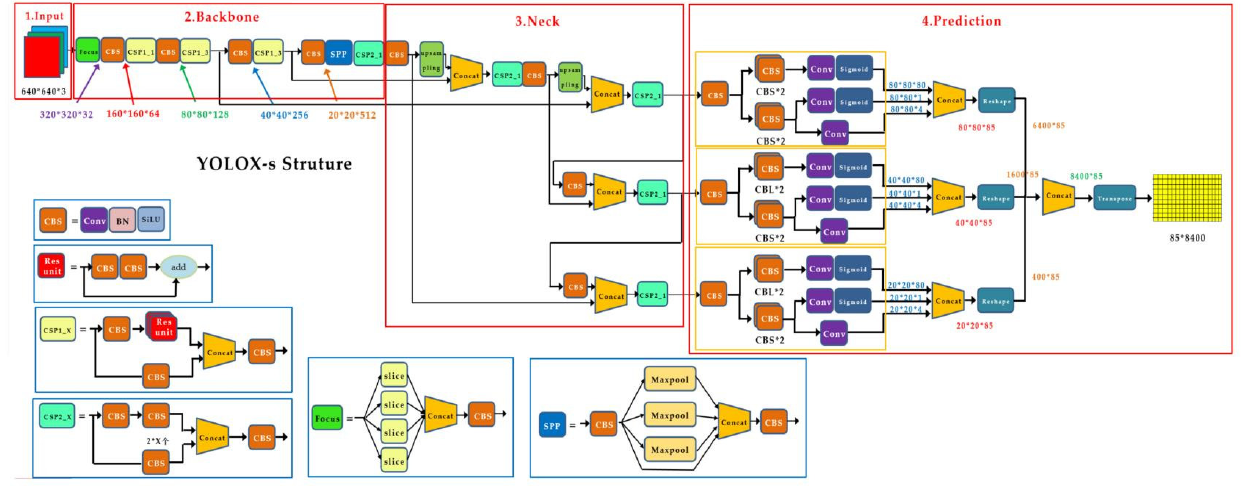
Figure 3. Structure of the YOLOX-S network model.